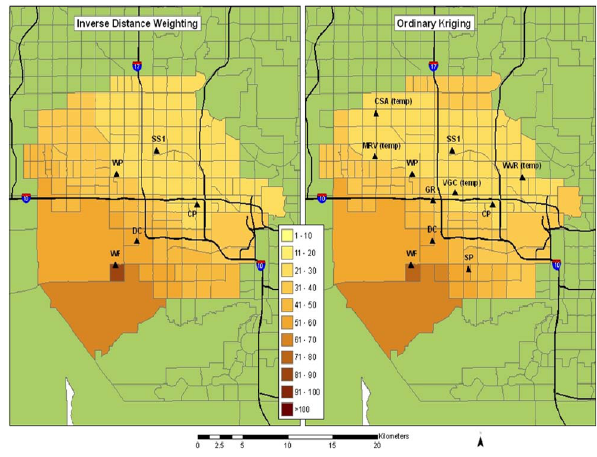
Fig. 3. PM 10 24-h concentration obtained (µgm − 3 ) using two dif- ferent methods: IDW and OK; 21 December 2007.